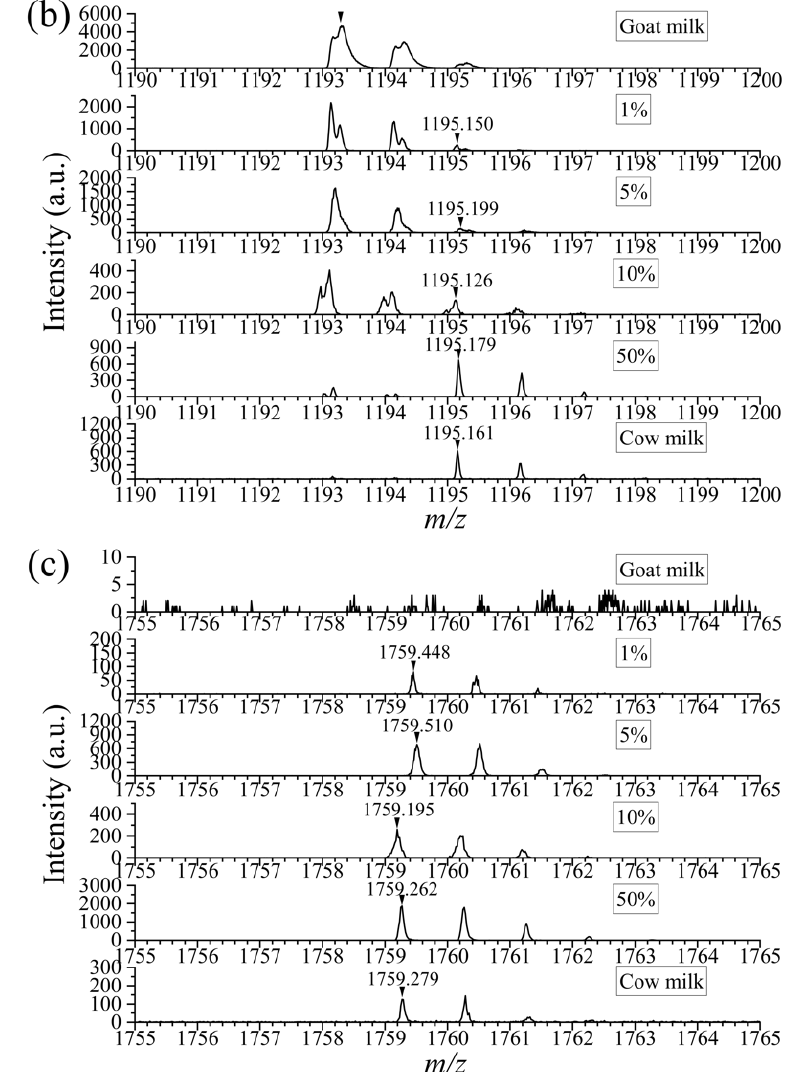
Figure 3. Comparison of mass spectra of specific peptides in goat milk mixed with cow milk at different volume ratios (0, 1%, 5%, 10%, 50%, 100%). m/z = 830 ( a ), 1195 ( b ), 1759 ( c ).